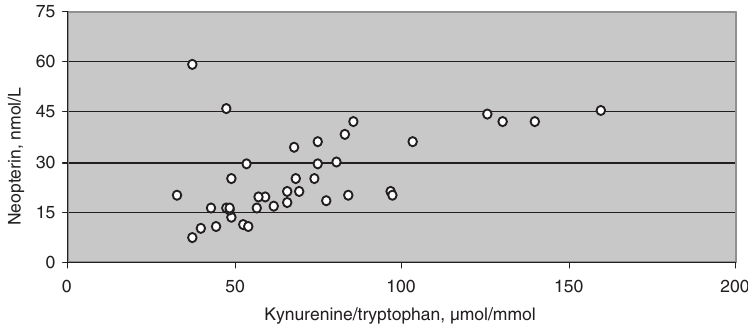
Figure 4 In patients with HIV-1 infection, a close association exists between the degree of tryptophan breakdown as is expressed by the kynurenine-to-tryptophan ratio (kyn/trp) and the concentrations of neopterin (n = 38; rs = 0.571, p < 0.0001), which confirms their immunobi- ological background in common, namely, Th1-type immune response and interferon- γ (for comparison, see ref.